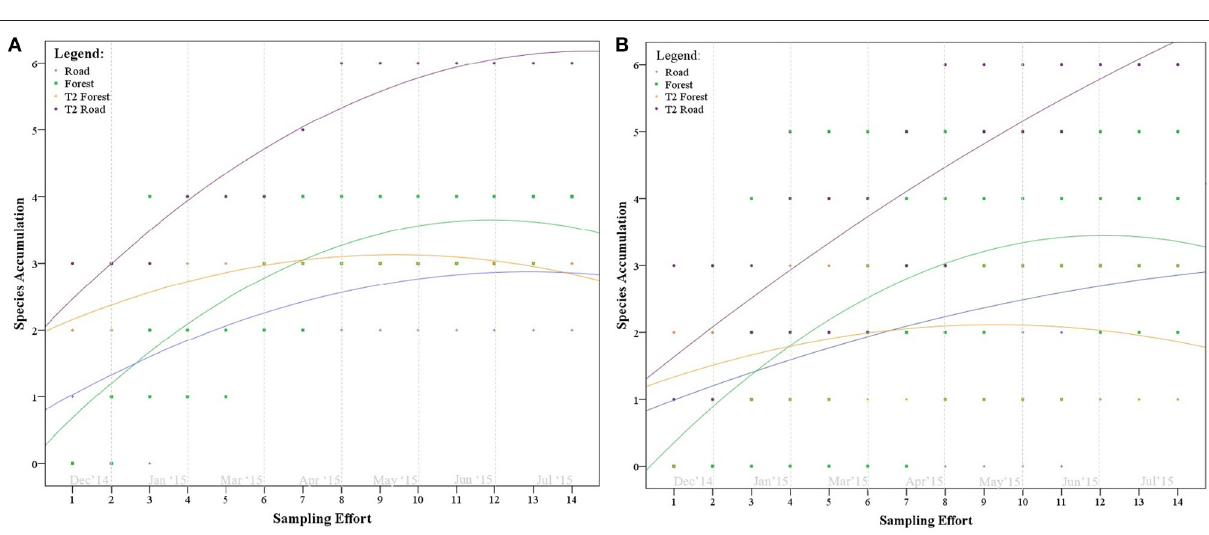
Contrary to initial predictions, call activity did not appear